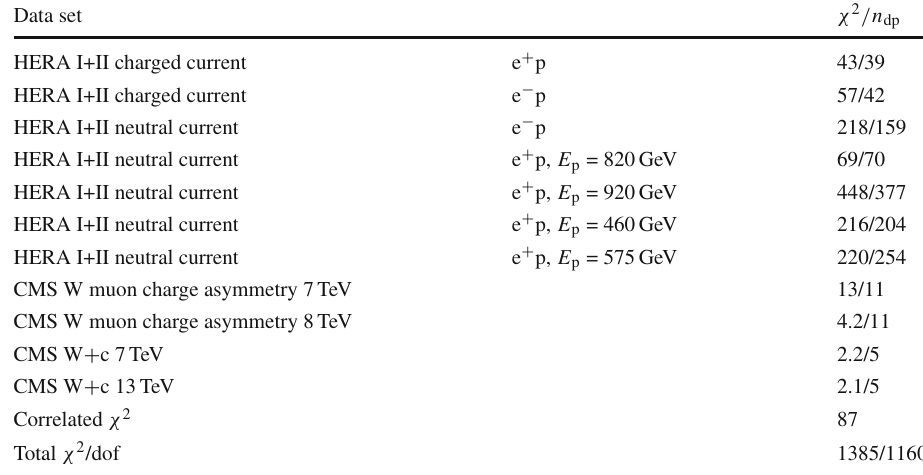
Table 6 The partial χ 2 per number of data points, n dp , and the global χ 2 per number of degree of freedom, n dof , resulting from the PDF